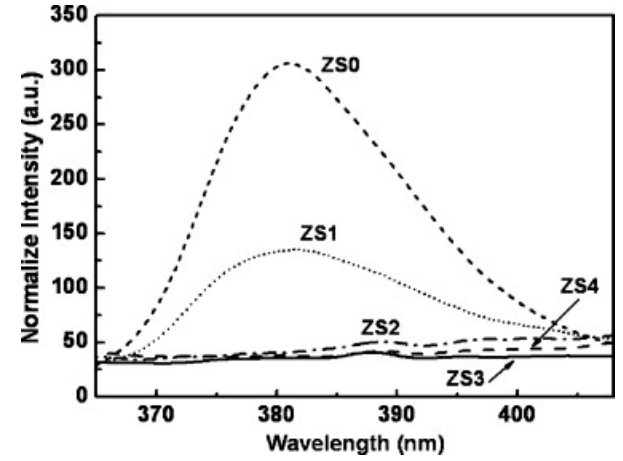
Figure 53. Photoluminescence (PL) emission spectra of ZnO/SnO 2 heterostructure with different ZnO: SnO 2 molar ratio. Reproduced with permission from [74].